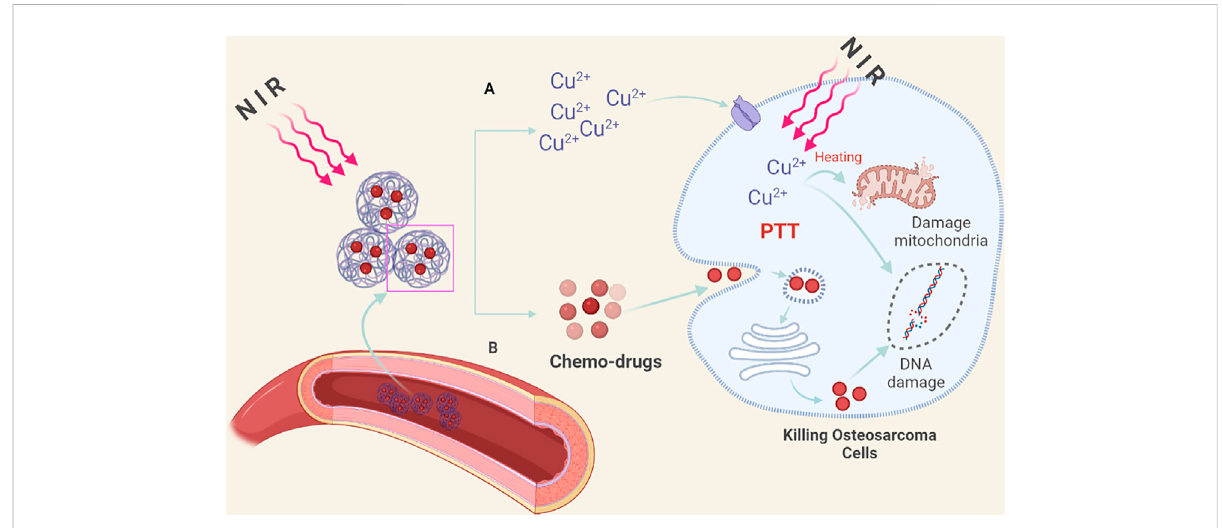
FIGURE 2 Nano-copper-based drug targeted delivery system. (A) Under the irradiation of NIR light, the nano-Cu-chemotherapy drug targeted delivery system decomposes and releases Cu 2+ locallyin the tumor, which can destroy the tumor cell membranestructure through PPT, kill tumor cells, and improve the sensitivity of chemotherapeutic drugs. (B) Under NIR light, the released chemotherapy drugs target tumor cells, causing DNA damage. At the same time, the damage to normal tissue cells is